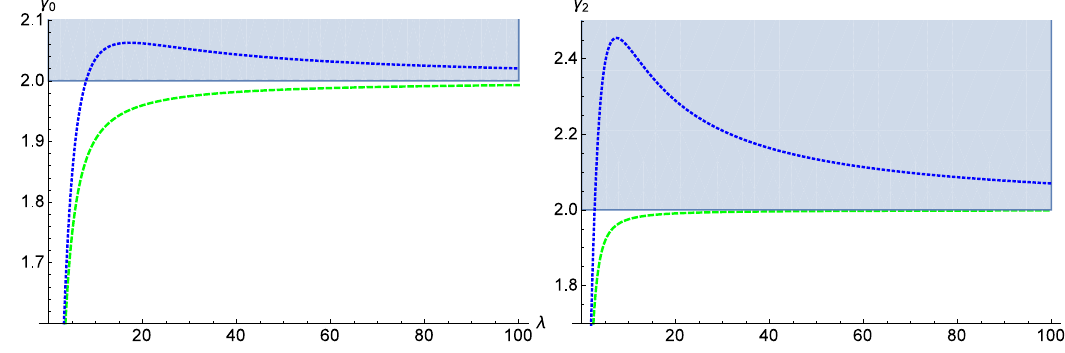
(blue dotted line) and F (30 ; 1 = 4) 4 4